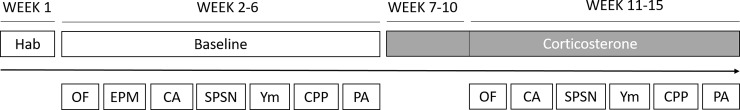
Order of tests.Open field (OP), elevated plus maze (EPM), 23h cage activity (CA), anhedonia (AnH), social preference and social novelty (SPSN), Y-maze spontaneous alternations (Ym), conditioned place preference (CPP), passive avoidance (PA).